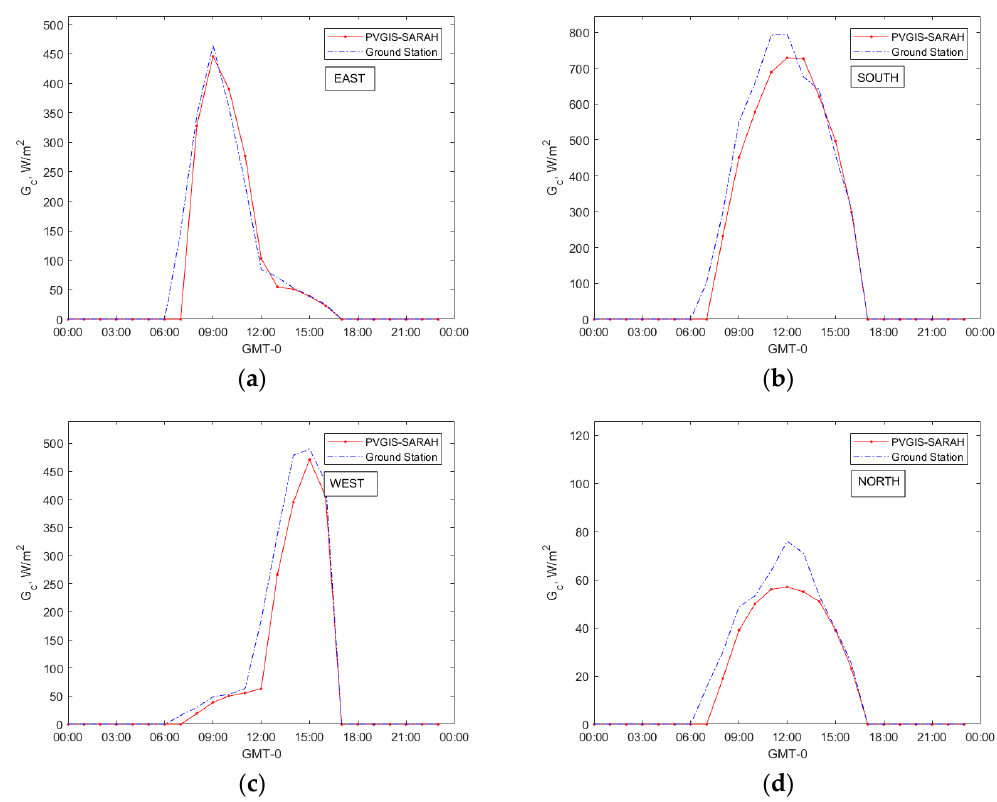
Figure 9. Comparison of the daily radiation profile for January from PVGIS-SARAH satellite-based database for a multi-year period (2005–2016) and from experimental measurements from in-situ ground station registered in the year 2018 at the considered location in Murcia (Spain). ( a ) East; ( b ) South; ( c ) West; ( d )